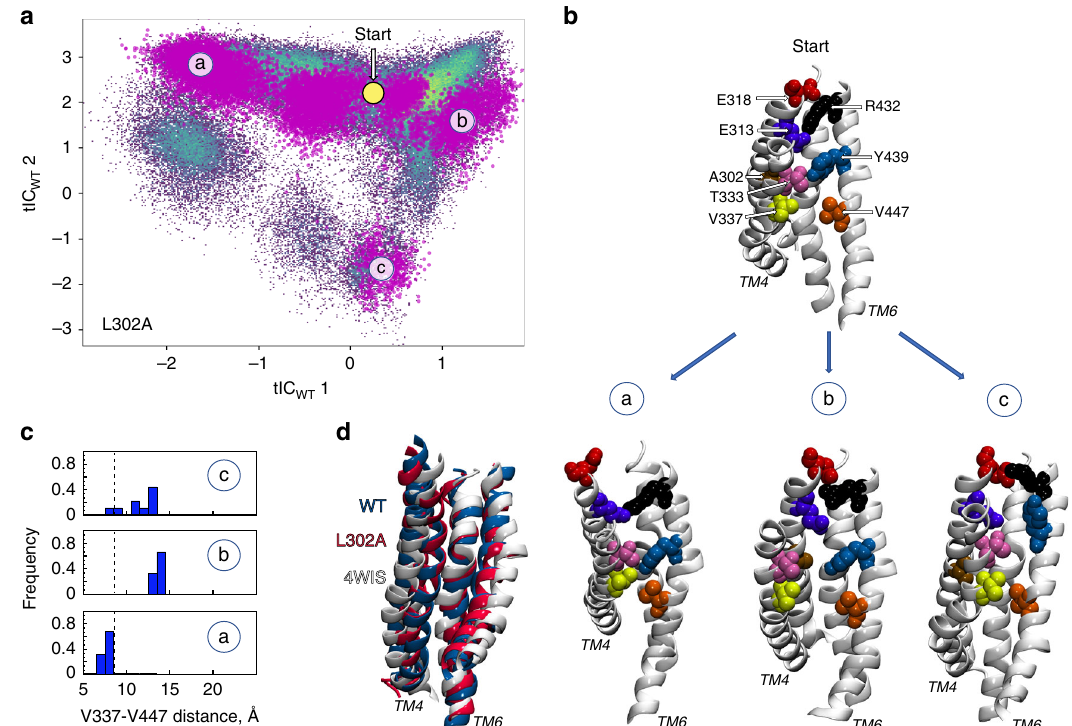
Fig. 5 Structural characteristics of occluded groove conformation in L302A nhTMEM16. a Projection of all the L302A trajectories (purple symbols) onto the 2D tICA landscape of the wild-type system from Fig. 1a. The dynamics of the two subunits of the protein in each trajectory were considered separately in the analysis. The location of the initial conformation of the system (the 4WIS X-ray model) is indicated on the 2D tICA landscape by the yellow circle marked Start. From this con fi guration, the L302A system evolved towards the microstates denoted by a – c described in the other panels (see also Supplementary Fig. 9). b Structural representation of the initial conformation of the L302A system and of the representative conformations of microstates a, b, and c. In these structural models, the relevant groove residues appear in space fi ll representations, and are labeled. c The probability distributions of the C α -C α distance between V337-V447 residues in microstates a, b, and c. The vertical dashed lines represent the 8.5 Å distance cut-off used to de fi ne the occluded conformation of the groove. d Structural superpositions with respect to the X-ray structure of the nhTMEM16 (PDBID: 4WIS; in white), of the groove regions (helices TM3-TM6) from the occluded groove conformation in the WT nhTMEM16 simulations (in blue) and from the L302A simulations (in red). The simulated structures of the wild type and the L302A nhTMEM16 are represented by the centroids of the respective ensemble of conformations (i.e., for the wild type — microstate 3 in Fig. 1a; for the L302A — microstate a in Fig. 5a, b)